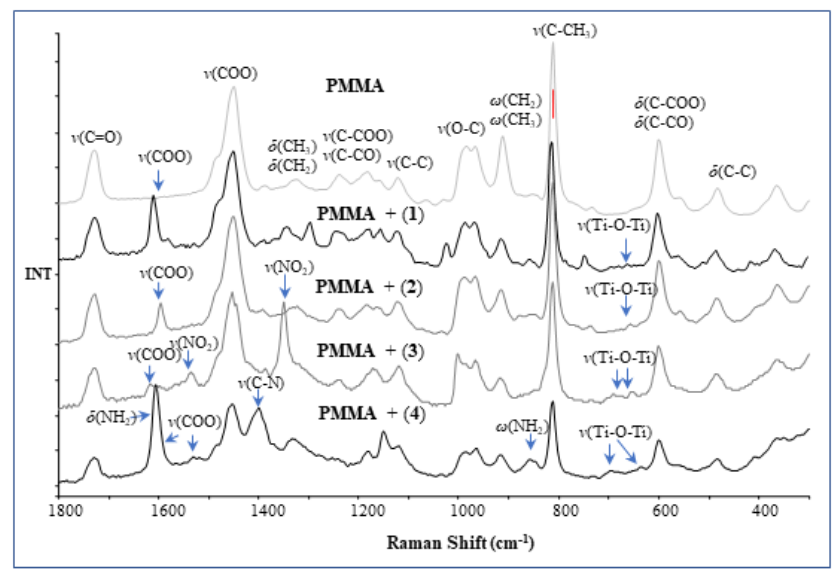
Figure 4. Raman spectra of poly(methyl methacrylate) (PMMA) and PMMA–titanium oxo-clusters (TOCs) composites. Arrows indicate the bands, derived from (1)–(4) complexes.